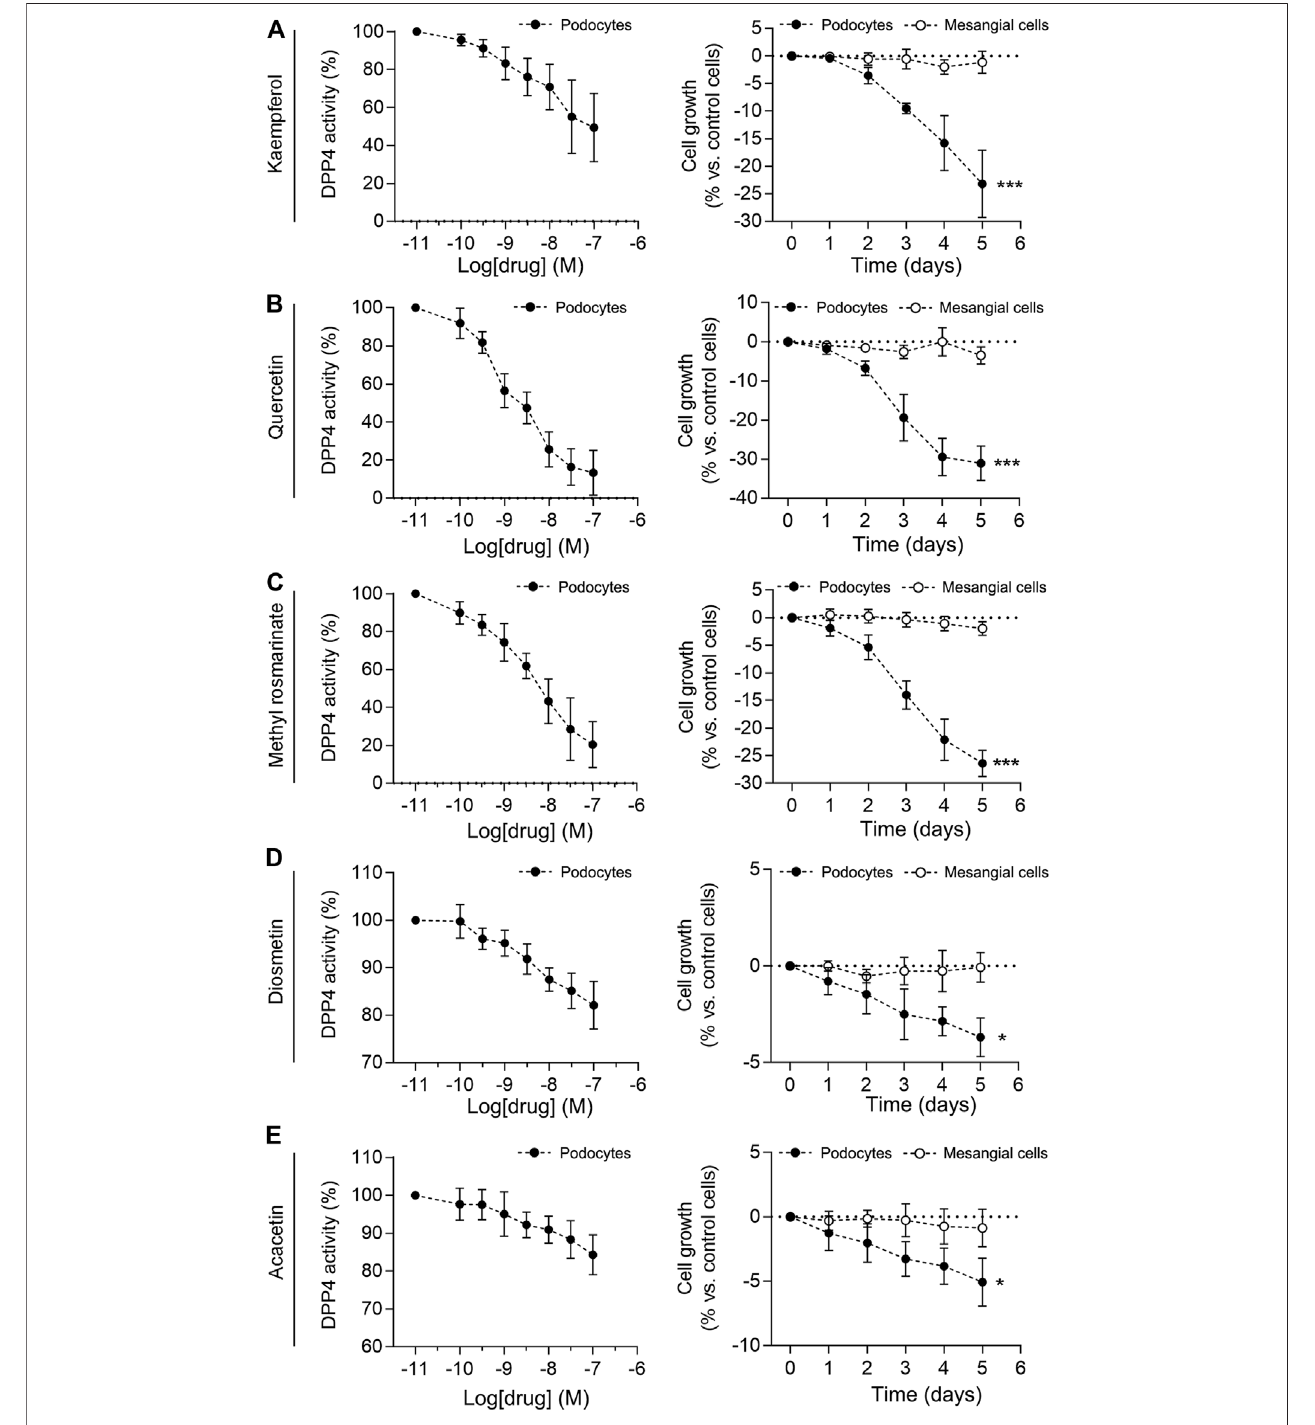
FIGURE 5 | Effect of compounds on DPP4 activity and cell growth in immortalized podocytes and mesangial cells. (A – E) Effects of increasing compounds concentrations (0.01 – 100 nM) on the enzymatic activity measured in immortalized human podocytes were shown in the left panel. Enzymatic activity was evaluated in cellextractsbymeasuringtherateofincreasein fl uorescenceintensity,expressed asarbitraryunits(A.U.) · min − 1 ,normalizedtoproteincontent.Tosetthe Y -axis,alldata were normalized to the mean value of the control group. Immortalized human podocytes and mesangial cells were exposed to either vehicle alone (control) or compounds for 5 days, and cell growth was measured by a colourimetric assay in the right panel. n (cid:1) 3. *p < 0.05, * ** p < 0.001 vs mesangiaal cells, by unpaired Student ’ s t